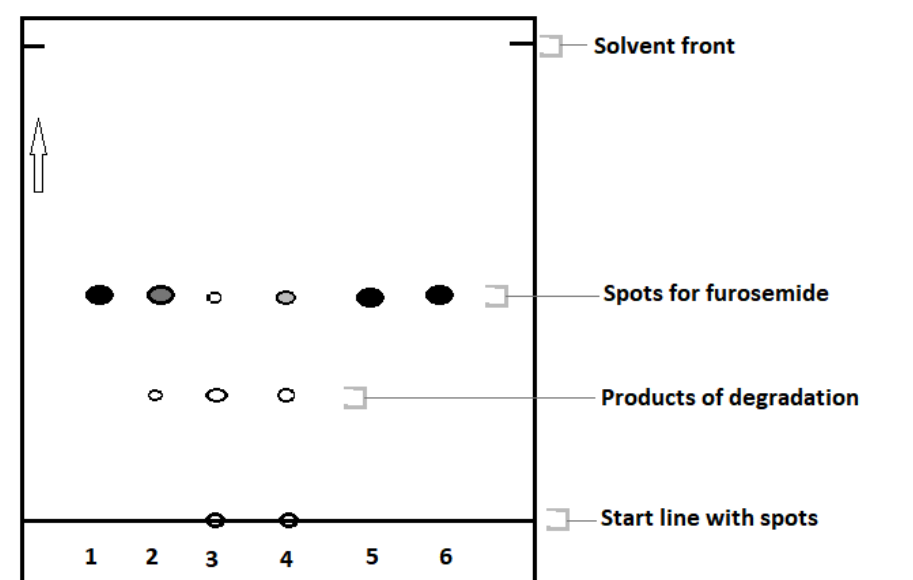
Fig 1. Schematic representation of chromatograph showing products of furosemide degradation as seen under the UV light. Spots with faint or no colour represent samples that underwent degradation under stress conditions. Key: 1 – reference solution, 2 – sample with H